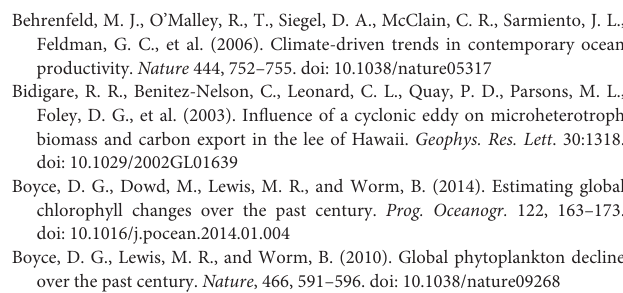
Figure S1 | Seascape determination of dynamic gyre geography. (A) Variance explained by satellite and model seascapes and the percent of pixels that have the same classification in space and time between satellite and modeled seascapes. (B) Cross-correlation of model and satellite time series of subtropical seascape expansion. (C) Cross-correlation of model and satellite time series of isolation of Station ALOHA. Figure S2 | Cross-correlation of MEI and PDO with NPGO. Figure S3 | Cross-correlation of geographic indicators. (A) Areal extent of low level chl a , extent defined by geostrophy, and isolation distance of Station ALOHA in relation to variations in subtropical seascape extent. (B) Areal extent of low level chl a , extent defined by geostrophy, and subtropical seascape extent in relation to variations in the isolation distance of Station ALOHA within the subtropical seascape. Figure S4 | Cross correlation analysis of climate indices and in situ surface properties at station ALOHA. Table S1 | Trends of subtropical expansion across geographic metrics, chl a algorithms, and time-series duration. Italicized values denote no significant trend over the duration measured. The effect of climate oscillations has not been